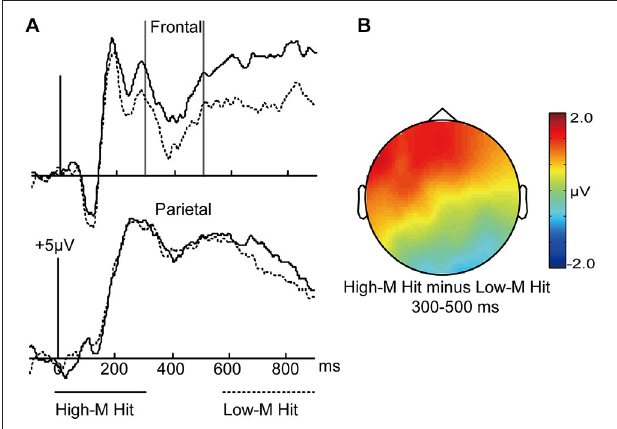
FIGURE 3 | ERPs for High-M hits and Low-M hits trials. (A) Waveforms are shown from midline frontal electrodes and parietal electrodes. Gray vertical lines indicate the significant time window (300–500 ms). (B) The topographical plot depicts ERP differences between High-M hits and Low-M hits.